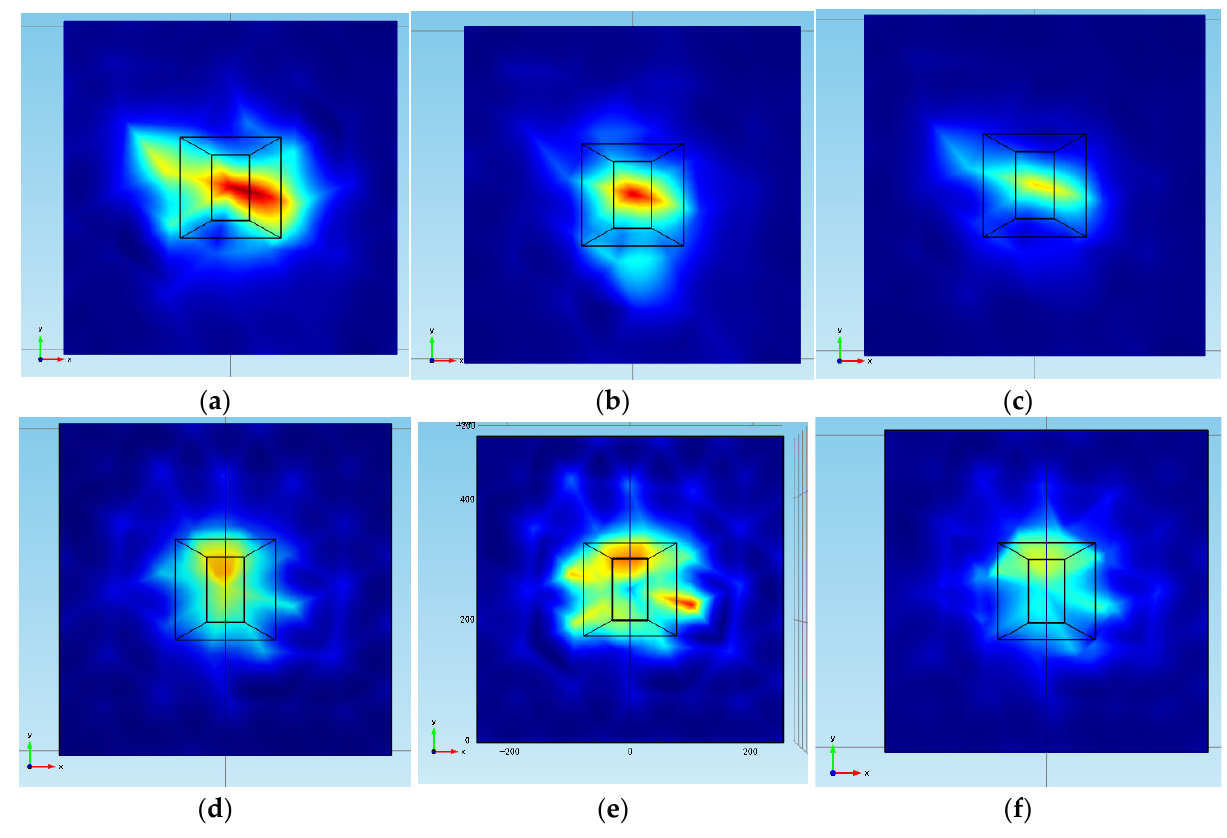
Figure 13. Simulation results of different ice layers and heights. ( a ) 20 mm, no ice; ( b ) 40 mm, no ice; ( c ) 60 mm, no ice; ( d ) 20 mm, no ice; ( e ) 40 mm, no ice; ( f ) 60 mm, no